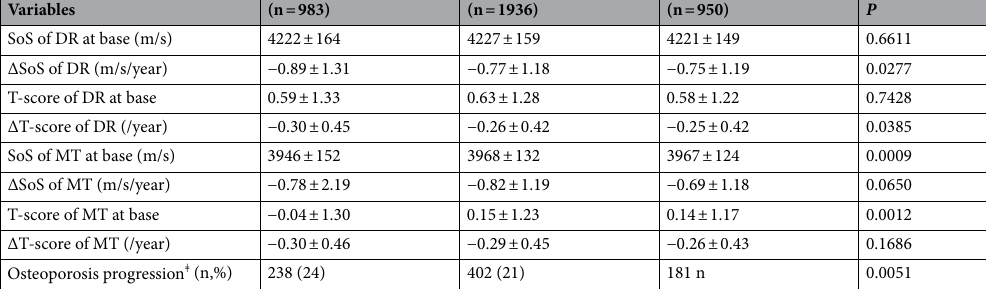
Table 1. General characteristics grouped according to e24UNaE Tanaka * (g/day). Results are expressed as mean ± SD or frequencies (and proportions). e24UNaE, estimated 24-h urine sodium excretion; BP, blood pressure; eGFR, estimated glomerular filtration rate; AST, Aspartate aminotransferase; ALT, Alanine aminotransferase; HDL, high-density lipoprotein; LDL, low-density lipoprotein; UACR, Urine albumin/Cr ratio; Cr, creatinine, Na, sodium; K, potassium; Ca, calcium; FE Na , fractional excretion of sodium; UKCR, urine potassium/creatinine ratio; UNaKR, urine sodium/potassium ratio; FE Ca , fractional excretion of calcium; SoS, speed of sound; DR, distal radius; MT, midshaft tibia. *e24UNaE calculated using Tanaka method. † Estimated using the Chronic Kidney Disease Epidemiology Collaboration equation. ǂ Defined as a bone mineral density T-score at ether distal radius or midshaft of tibia below